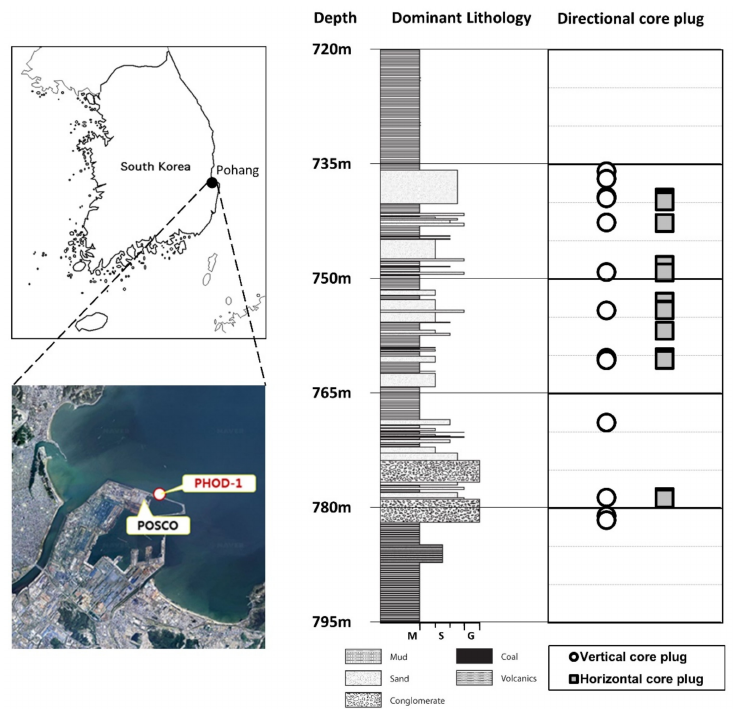
Figure 1. Geological stratigraphic section with sampling locations from the Pohang basin, offshore Southeast